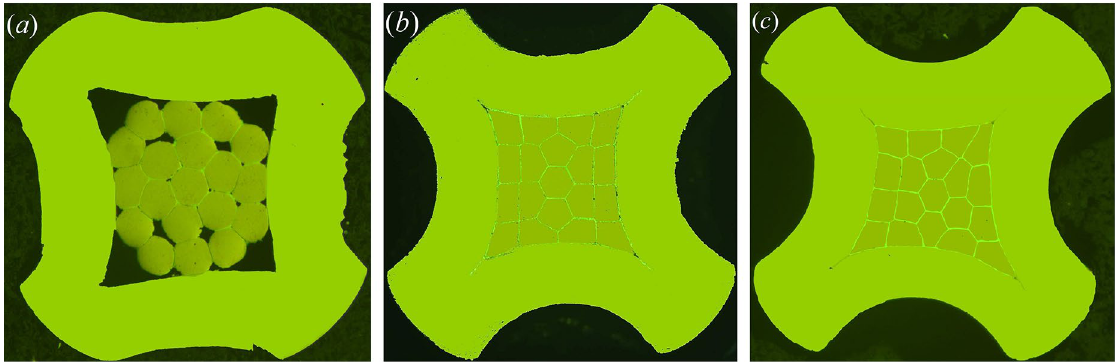
Figure 4. Morphological characteristics of crimped cross-sections with different indentation depths. ( a ) Insufficient crimping. ( b ) Reasonable crimping. ( c ) Excessive crimping.